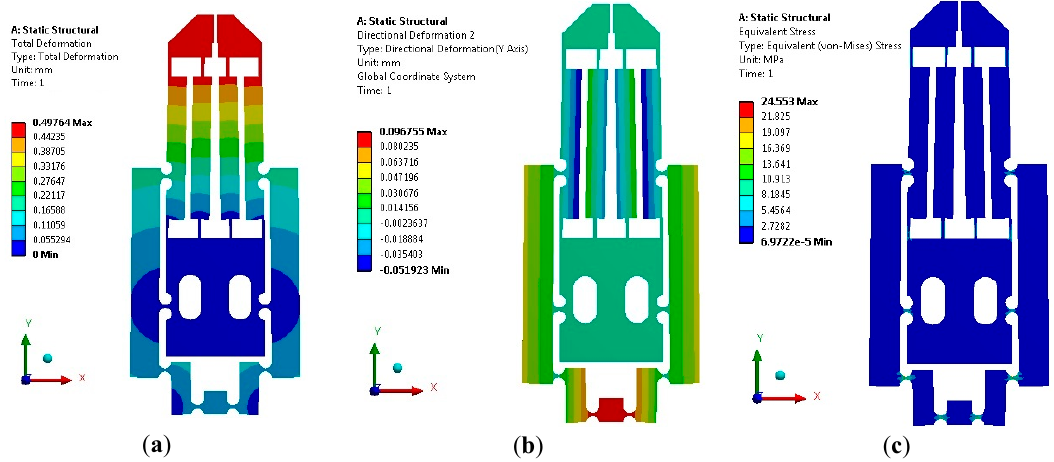
Figure 5. Performance of the MG when an input force of 2.5 N is applied. ( a ) Total and ( b ) directional deformation in Y-axis. ( c ) Equivalent stress distribution.